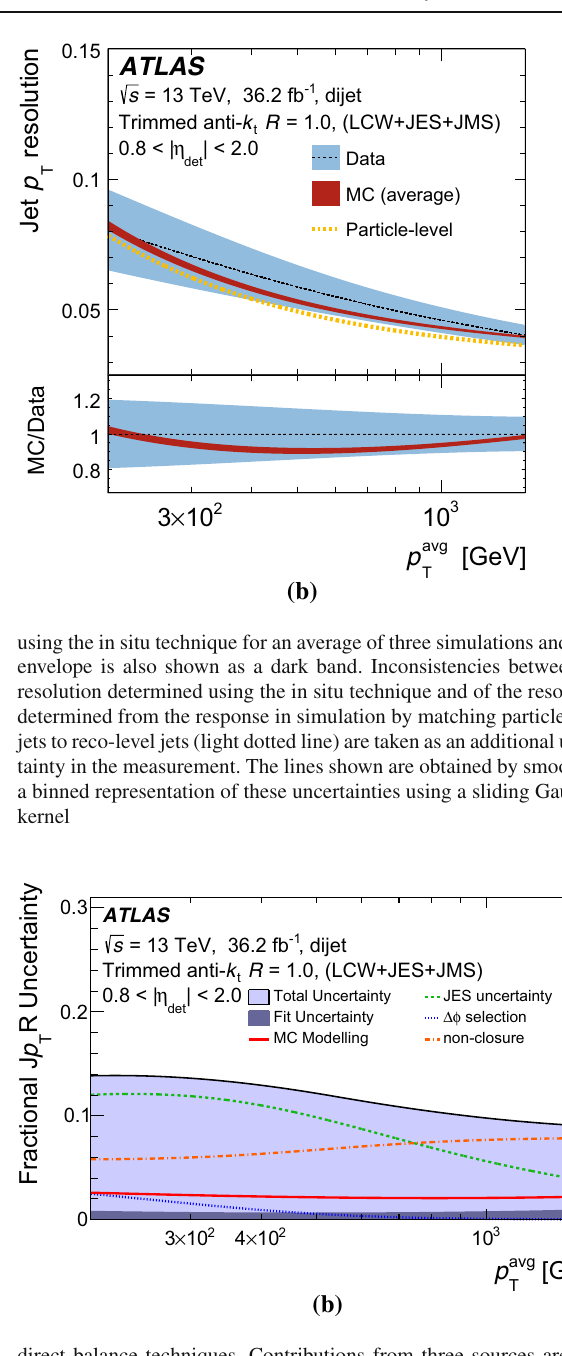
direct balance techniques. Contributions from three sources are esti- mated separately by propagating the uncertainty in the energy scale to the measurement, by varying the (cid:4)φ selection, and by varying the event generator. The lines shown are obtained by smoothing a binned representation of these uncertainties using a sliding Gaussian kernel